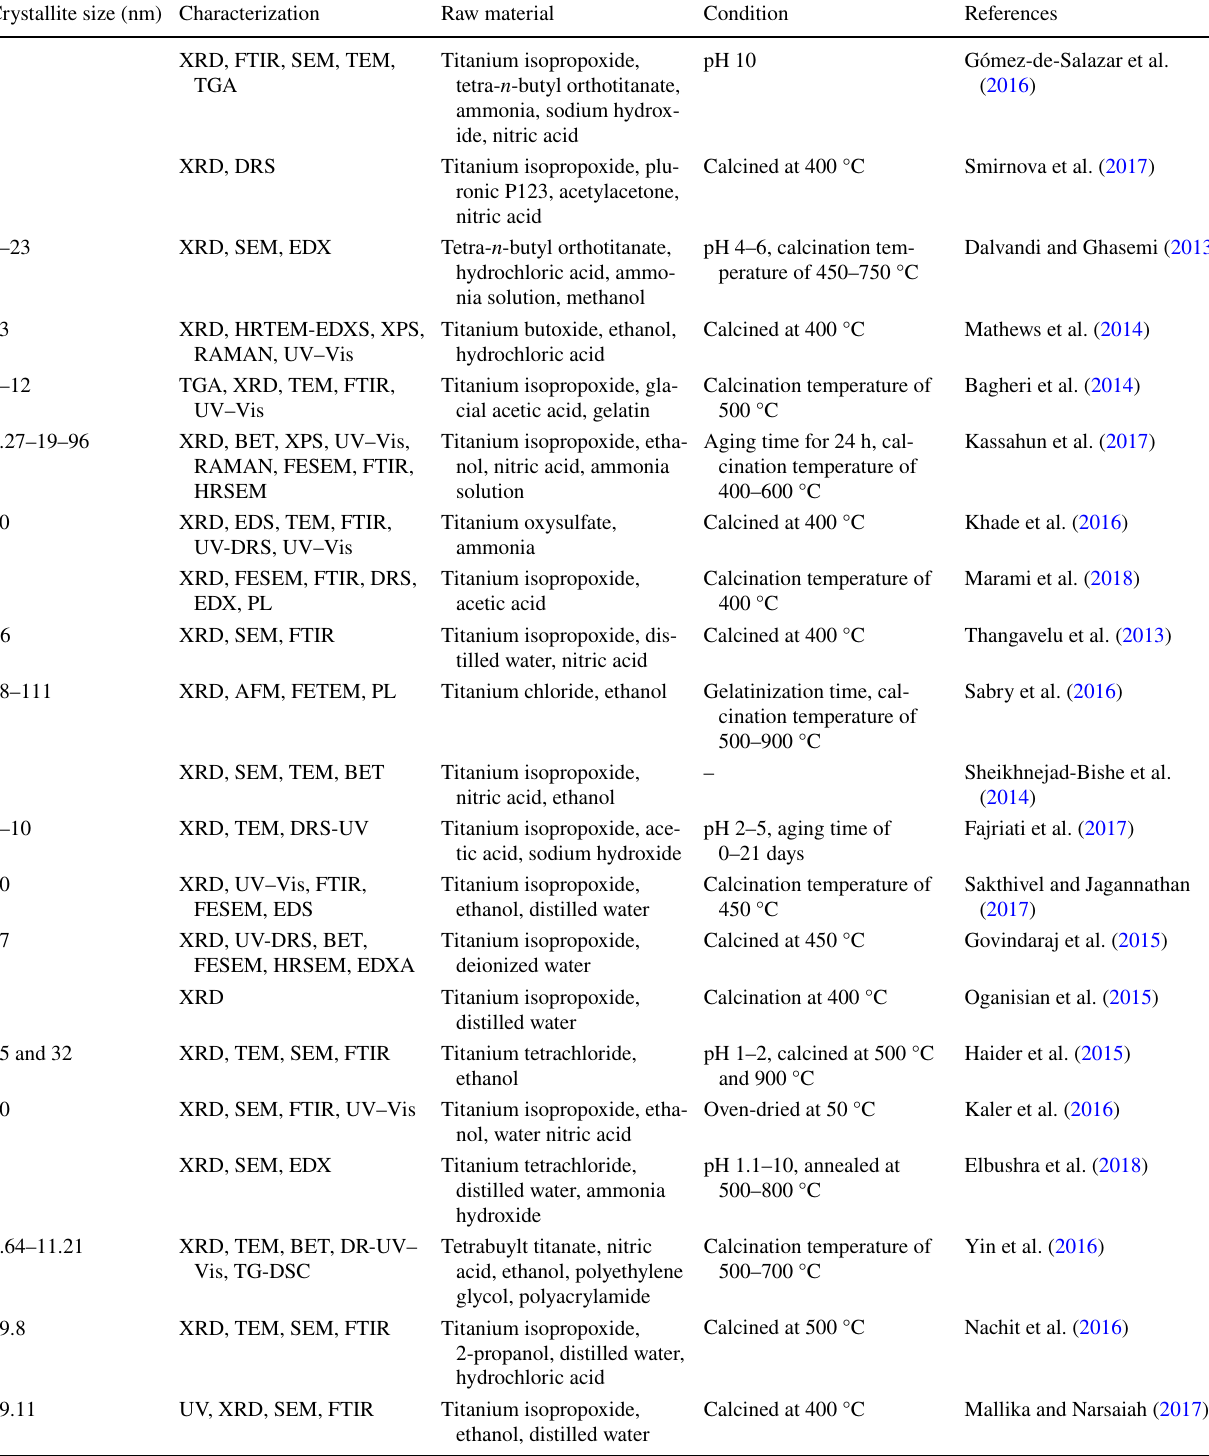
ticles using solgel. 2 nanoparticles via solgel method from 2013 to 2018